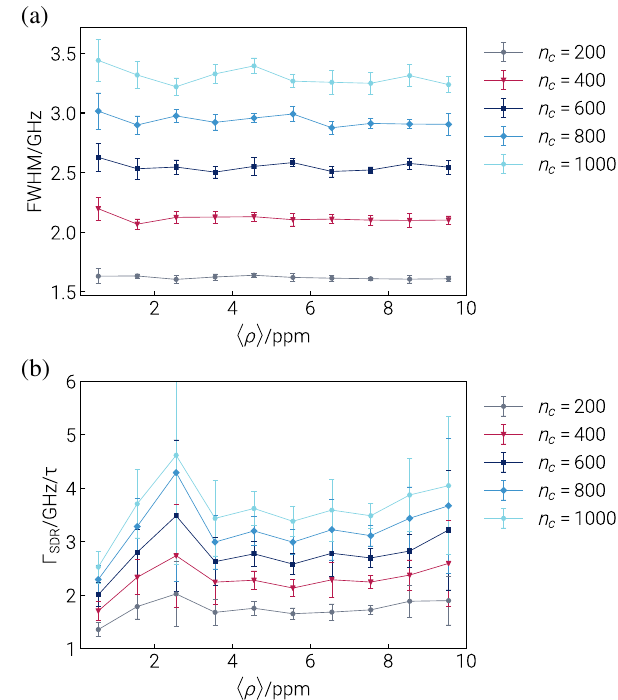
FIG. 14. Effect of trap densities. (a) Inhomogeneous linewidth and (b) spectral diffusion rate as a function of the trap density ρ = ppm for a range of charges and for 10 000 different configu- rations. Each point is averaged over ten trap densities equally spaced within 1-ppm increments. The error bars represent the standard deviation for both the linewidths and diffusion rates. The trap density appears to have little impact on the line broadening and the spectral diffusion range. The time step for the spectral diffusion rate is fixed to some arbitrary value, as it does not impact the qualitative behavior of the spectral diffusion